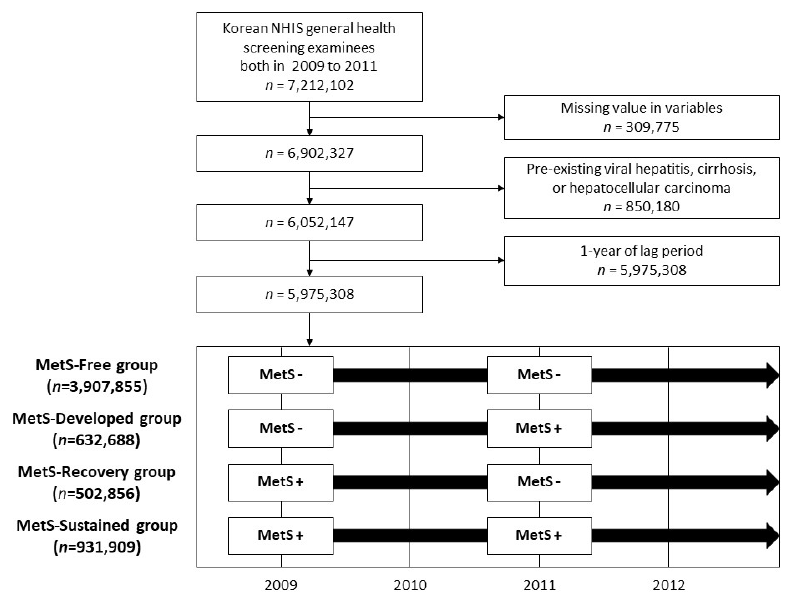
Figure 1. Flow chart of the study population selection process. MetS, metabolic syndrome.